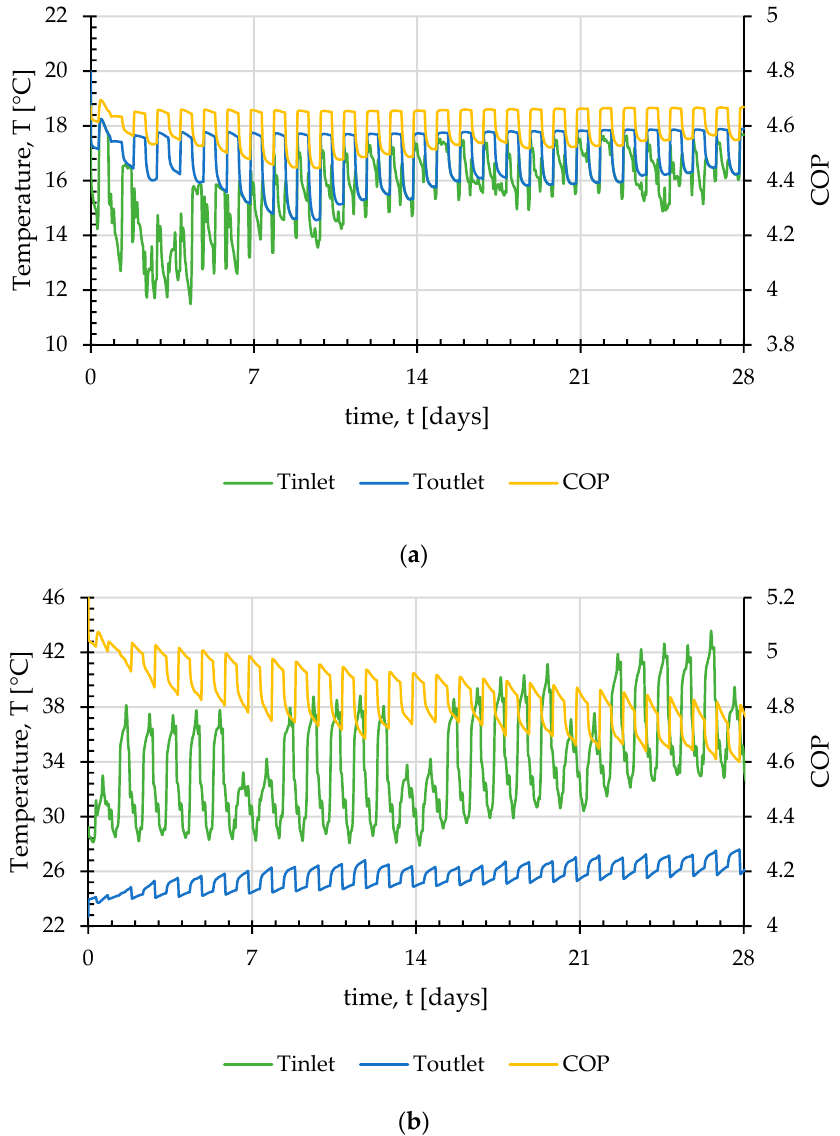
Figure 10. Foundation bed temperatures and performance for the months of (a) February and (b) July.